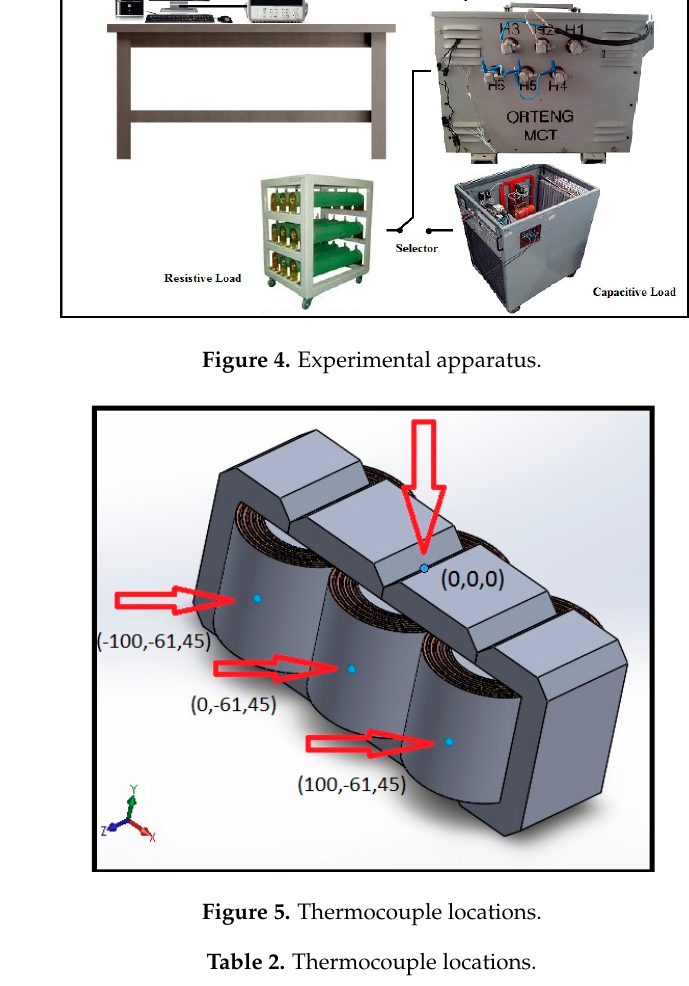
Figure 4. Experimental apparatus.